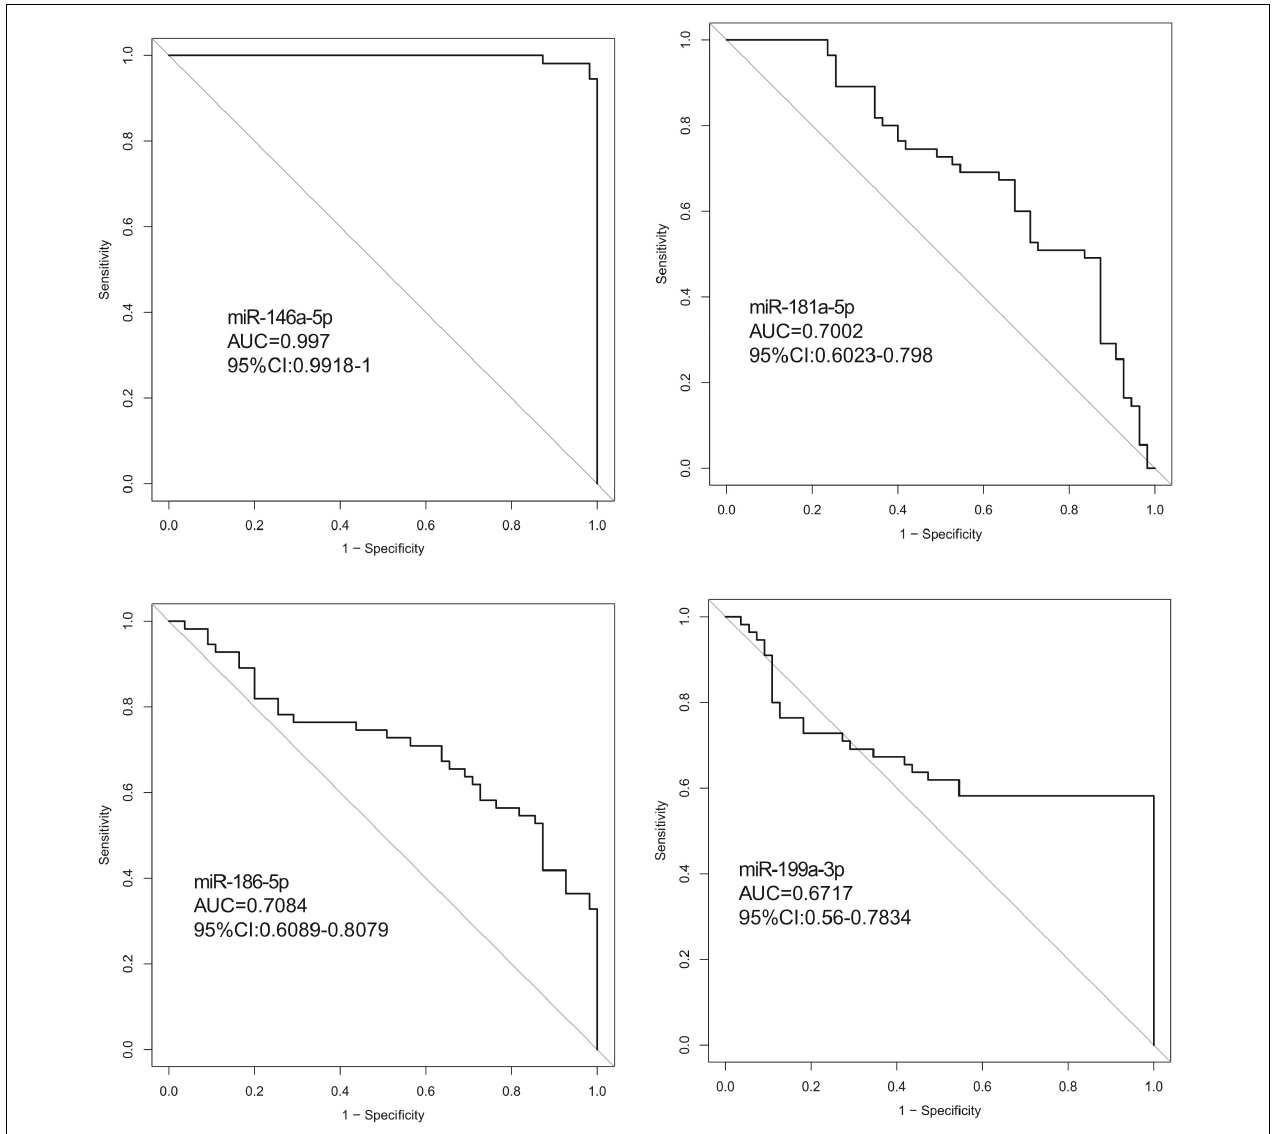
FIGURE 5 | ROC curve analysis between the VSD and control groups. (ROC curve (AUC) analysis indicted that the expression values of serum exosomal miRNAs had good predictive accuracy). Exosomal hsa-miR-146a-5p in the cohort was the optimal cut-off point. ROC curve: Receiver operating characteristic curve. TABLE 2 | Diagnostic efficiencies of serum exosomal miRNA in discriminating between fetuses with VSDs and controls. miRNA n AUC 95%CI p Cut-off Specificity Sensitivity Accuracy miR-146a-5p 0.9918–1 <